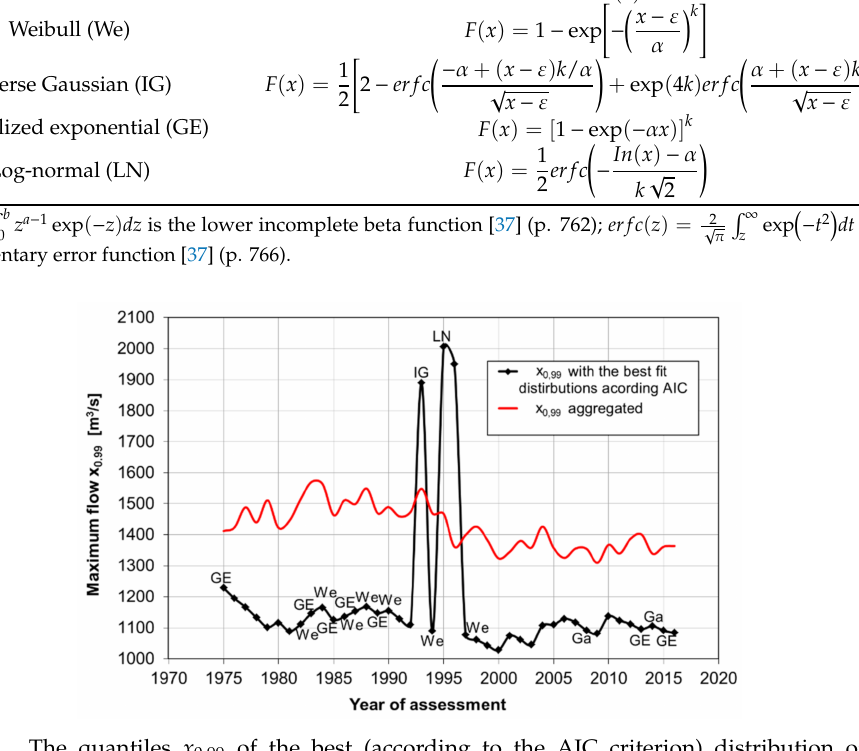
Figure 2. The quantiles x 0.99 of the best (according to the AIC criterion) distribution of the maximum summer flows in Koszyce Wielkie station along with an increasing number of observation series and quantiles aggregated by quantile magnitude method (MM) from candidate